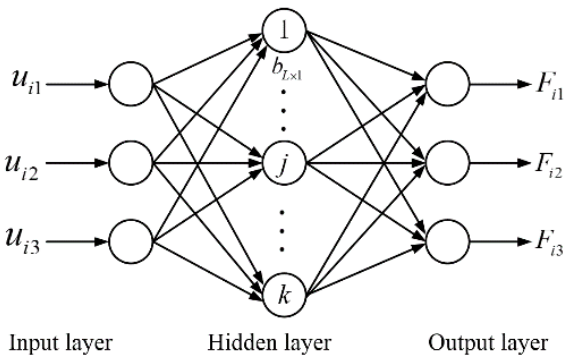
Figure 6. Network architecture based on ELM.